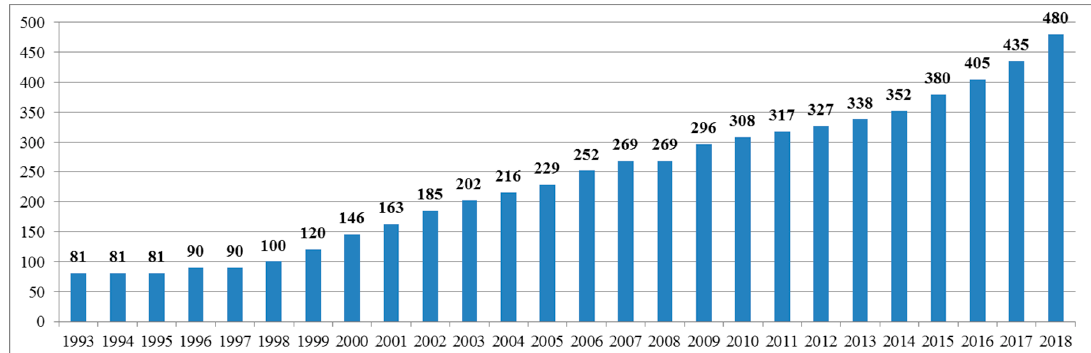
Figure 1. Historical overview of the minimum wage growth in the Slovak Republic (in EUR). Source: Compiled by the authors.